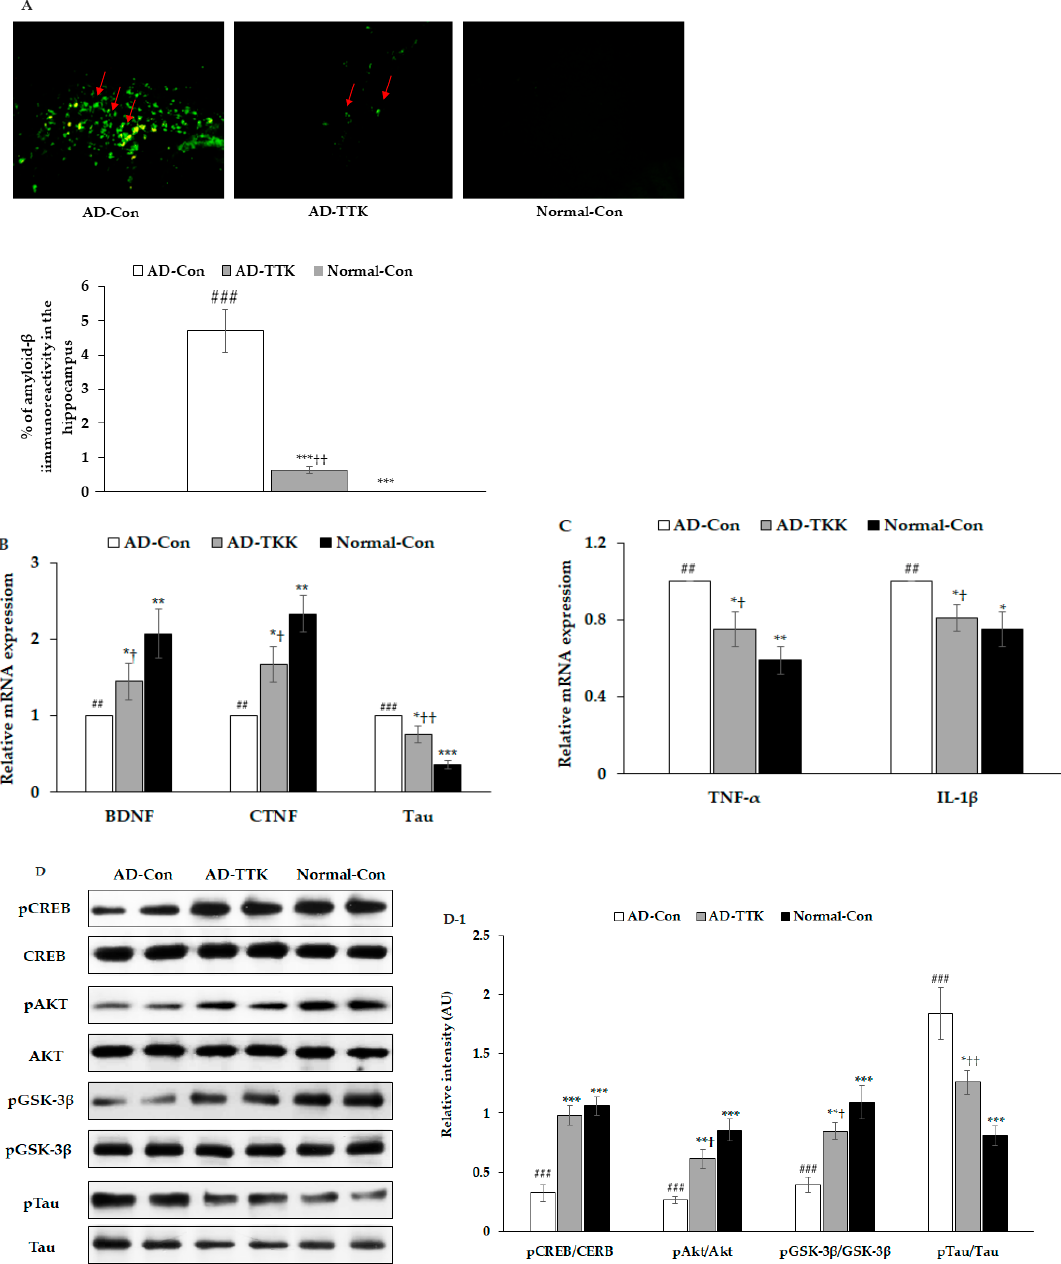
Figure 4. Amyloid- β deposition, expression of brain growth factor and neuroinflammation and insulin signaling in the hippocampus. ( A ) Amyloid- β accumulation in the hippocampus by immunohistochemistry staining with amyloid- β antibody (X200). Green fluorescent dots indicated the amyloid- β staining. ( B ) Hippocampal mRNA expression of BDNF, CNTF, and Tau. ( C ) Hippocampal mRNA expression of TNF- α and IL-1 β . ( D , D-1 ) Hippocampal insulin signaling and its intensity measured by an image analyzer. AD-Con fed 45% fat diet with 0.5% dextrin in AD rats infused intra-CA1 infusion of amyloid- β (25–35), AD-TTK fed 45% fat diet with 0.5% water extract of Tetragonia tetragonioides (TTK) in AD rats, and Normal-Con fed 45% fat diet with 0.5% dextrin in non-AD rats infused intra-CA1 infusion of amyloid- β (35–25). Each bar represents Means ± SD ( n = 4). # Significantly di ff erent among the groups in one-way ANOVA at p < 0.05, ## p < 0.01 and ### p < 0.001. * Significantly di ff erent from AD-Con at p < 0.05, ** p < 0.01, and *** p < 0.001 in the Tukey test. † Significantly di ff erent from the Normal-Con at p < 0.05 and †† p < 0.01 in the Tukey